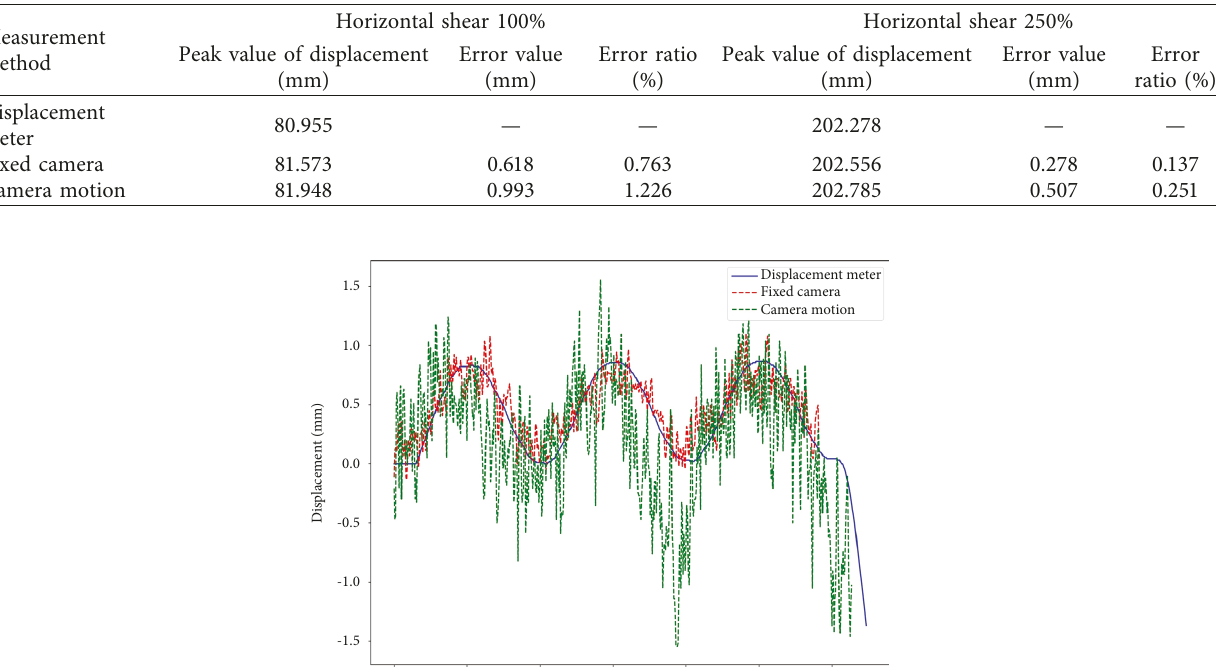
Table 3: Horizontal peak displacement is achieved by various displacement measurement methods.